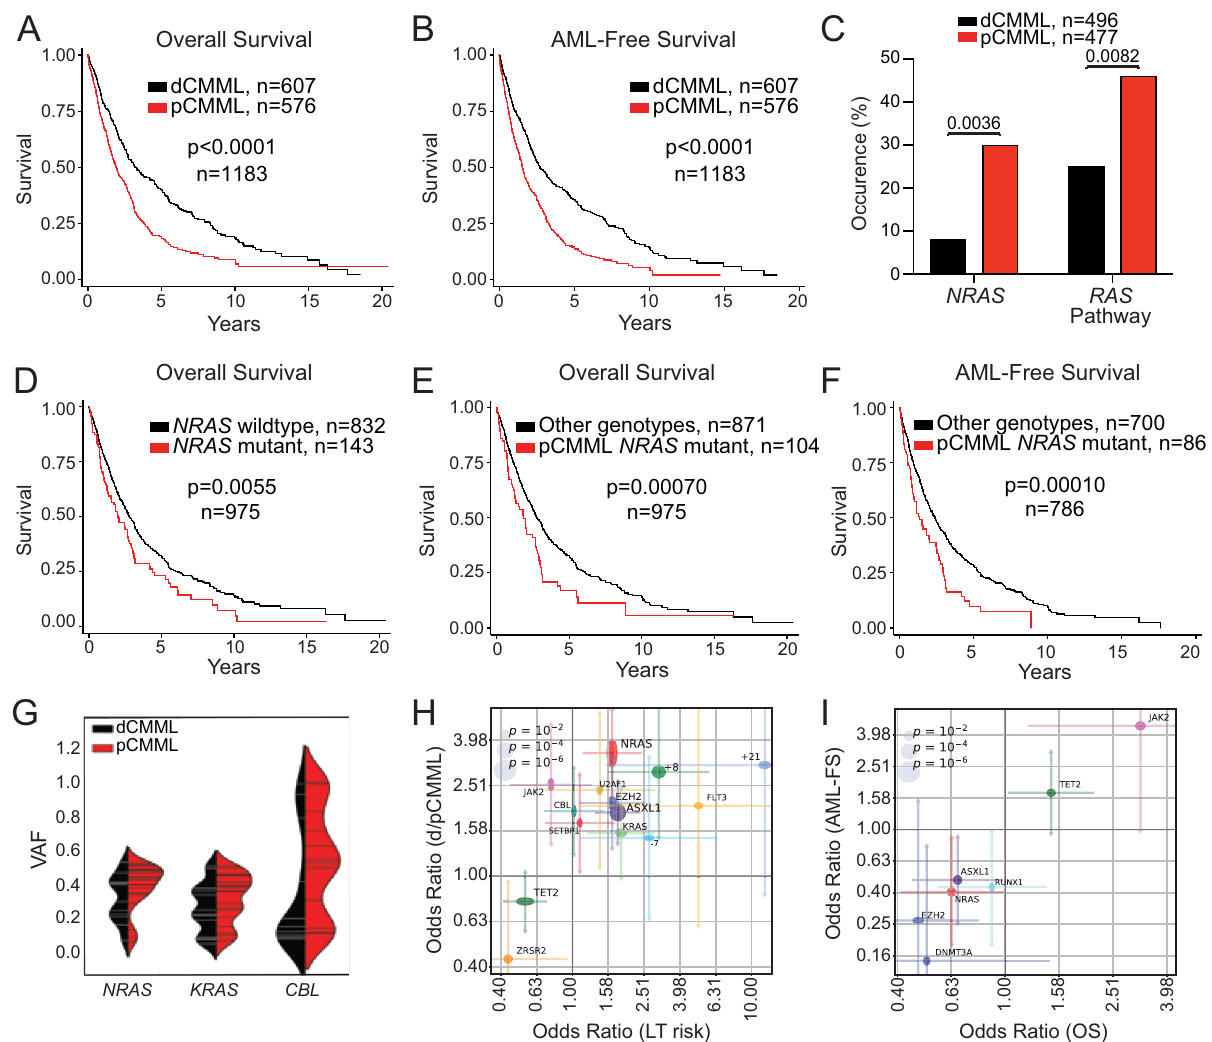
Fig. 1 RAS pathway mutations correlate with WHO-de fi ned proliferative chronic myelomonocytic leukemia (pCMML). A . Kaplan – Meier curve depicting overall survival (OS) of CMML patients from the Mayo-GFM-Austrian cohort strati fi ed by dCMML and pCMML subtypes. B Kaplan – Meier curve depicting AML-free survival. C Prevalence of NRAS and RAS pathway mutations in dCMML and pCMML by next generation sequencing. D Kaplan – Meier curve depicting OS of CMML patients strati fi ed by NRAS wild type and NRAS mutant cases. E Kaplan – Meier curve depicting OS in pCMML patients with NRAS mutations relative to other CMML genotypes. F Kaplan – Meier curve depicting AML-free survival in pCMML patients with NRAS mutations relative to other CMML genotypes. G Violin plots representing variant allele frequencies (VAFs) of the most frequent RAS pathway mutations in dCMML and pCMML. VAF is depicted on the y-axis. Width of horizontal hatches correlates to number of samples with the indicated VAF. H , I Odds ratios of genetic factors selected by L1-regularized logistic regression model that have the greatest impact on clinical parameters. H Impact on dysplastic/proliferative CMML categorization and leukemic transformation (LT) risk. The x -axis represents odds ratios of LT risk. The y -axis represents categorization of low or high white blood cell (WBC) count, or pCMML vs dCMML classi fi cation. I Impact on AML-free survival (LFS) and OS. The x - and y -axes represent odds ratios of binarized OS and LFS values, respectively (by the median). The horizontal and vertical size of ellipses re fl ects corresponding p -values. Con fi dence intervals ( ɑ = 0.05) of odds ratio values are presented. p -values are indicated with each Compared to chronic phase CMML, additional driver mutations Paired whole-exome sequencing (WES) performed on BM or (median = 2) were detected in 44% of LT samples (Supplemen- PB mononuclear cells (MNC) collected at both chronic phase tary Fig. 2B – E). The most striking changes included an increase CMML and sAML stages in a cohort of 48 patients were analyzed in mutations of the oncogenic RAS pathway (from 52 to 67%), (Supplementary Table 3). Median OS was 25 months after and in SCNA (from 52 to 75%; Fig. 2A, B and Supplementary diagnosis and 6.4 months after LT. At CMML diagnosis, or fi rst Fig. 2). referral to study institution, mutations in driver genes (detected Tracing clonal evolution from CMML onset to LT, we in every patient; mean, 3.6 per patient) and somatic copy number categorized driver mutations (Table S4 for de fi nition of driver alterations (SCNA; Fig. 2A, B and Supplementary Fig. 2A) were mutations) into those detected in CMML and at LT (primary comparable to previous reports 6 . Some mutations, such as in TET2, SRSF2 , and ASXL1, were predominantly clonal while drivers or 1d), only in LT (secondary drivers, 2d) and those in others, including the oncogenic RAS pathway, such as NRAS , CMML and lost in LT, suggesting sub clonal secondary drivers KRAS , and CBL , showed a bimodal distribution of VAF (Fig. 2C). (3d; Supplementary Fig. 2D). Secondary drivers (2d and 3d) were